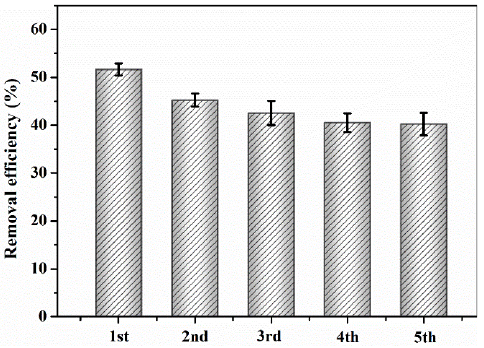
Figure 12. Recycling test of RhB adsorption by CBC ‐ Fe(II) (adsorbent dosage: 30 mg, initial dye concentration: 600